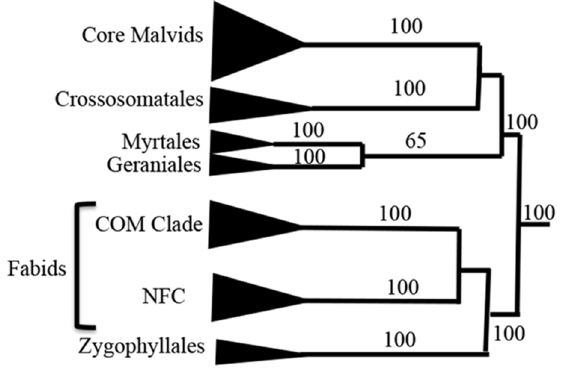
Figure 1. A summarized backbone relationships among the rosids lineages based on Wang et al. [19] phylogenetic study. A total evidence maximum likelihood rosid tree redrawn from Wang et al. (2009) with percent bootstrap support values $ 50% noted on branches. COM: Celastrales, Malpighiales, and Oxalidales. NFC (Nitrogen Fixing Clade): Rosales, Fabales, Cucurbitales, and Fagales. The malvids clade includes the basal three orders Myrtales + Geranials/Crossosoma- tales as sister to the core group.